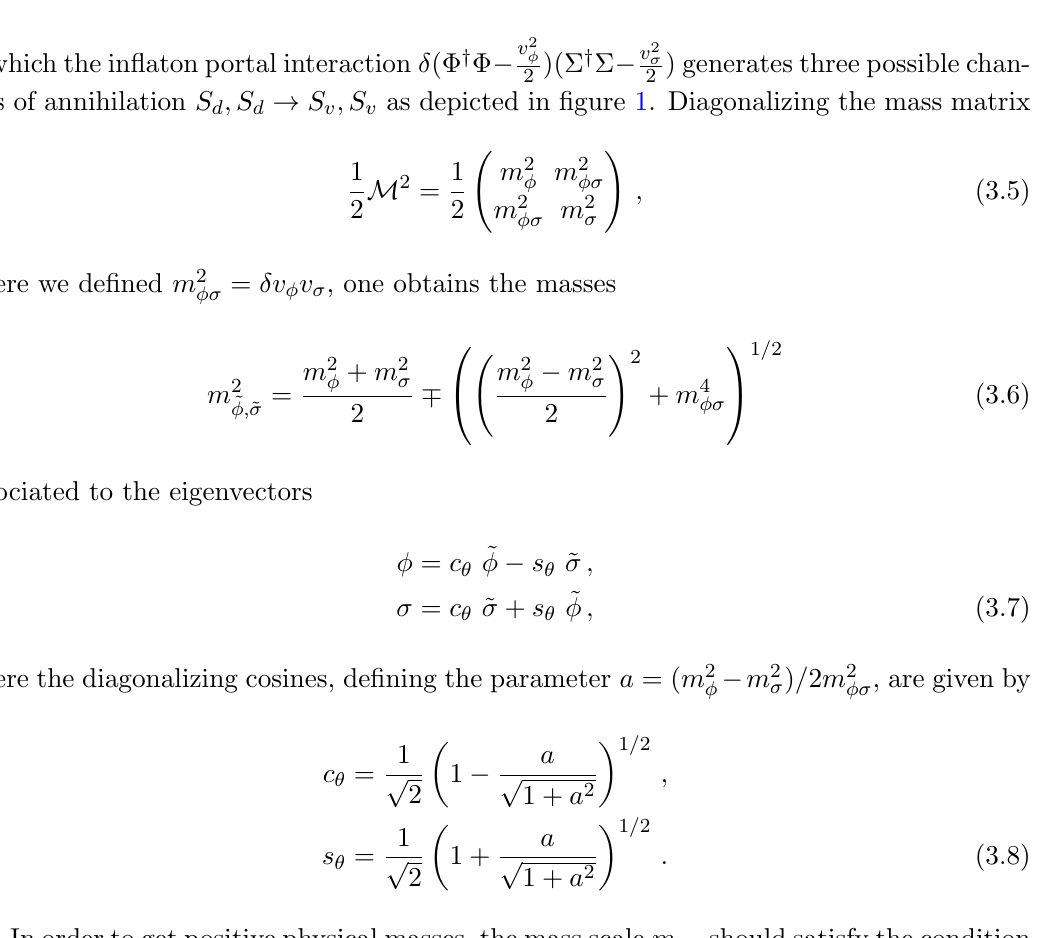
Figure 1 . Diagrams after rotation into the physical basis ( ~ (cid:30); ~ (cid:27) ) leading to annihilation of dark matter into the visible